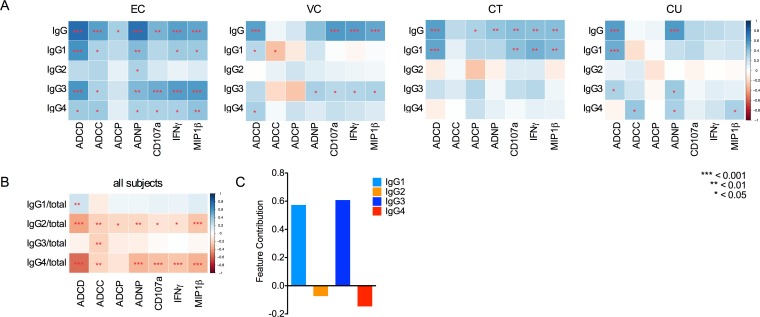
Antibody functionality can be predicted by subclass composition.
A. Correlative relationships between levels of total gp120-specific IgG or gp120-specific antibodies of each subclass to antibody function were assessed by determination of Spearman’s rank correlation coefficients between activity and antibody MFI within each subject group. B. Correlative relationships between relative levels of gp120-specific antibodies of each subclass (i.e., MFI of subclass/MFI of total IgG) were assessed for each functional activity, over all subjects. Positive associations are noted in blue and inverse associations in red, with the magnitude of correlation depicted by intensity. Correlative relationships and significance were calculated and visualized using R, with unadjusted p values indicated to facilitate relative comparisons. C. The magnitude and direction of the contribution of SF162-specific antibody subclass assessments to cross-validated predictive models of polyfunctional activity.